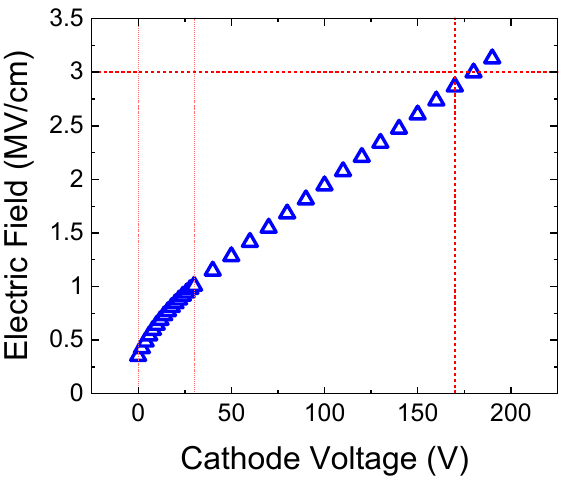
Figure 11. Electric field profile versus voltage for N A = 6 × 10 19 cm − 3 , corresponding to the devices under test, illustrating a field value ≈ 3 MV/cm at 170 V.